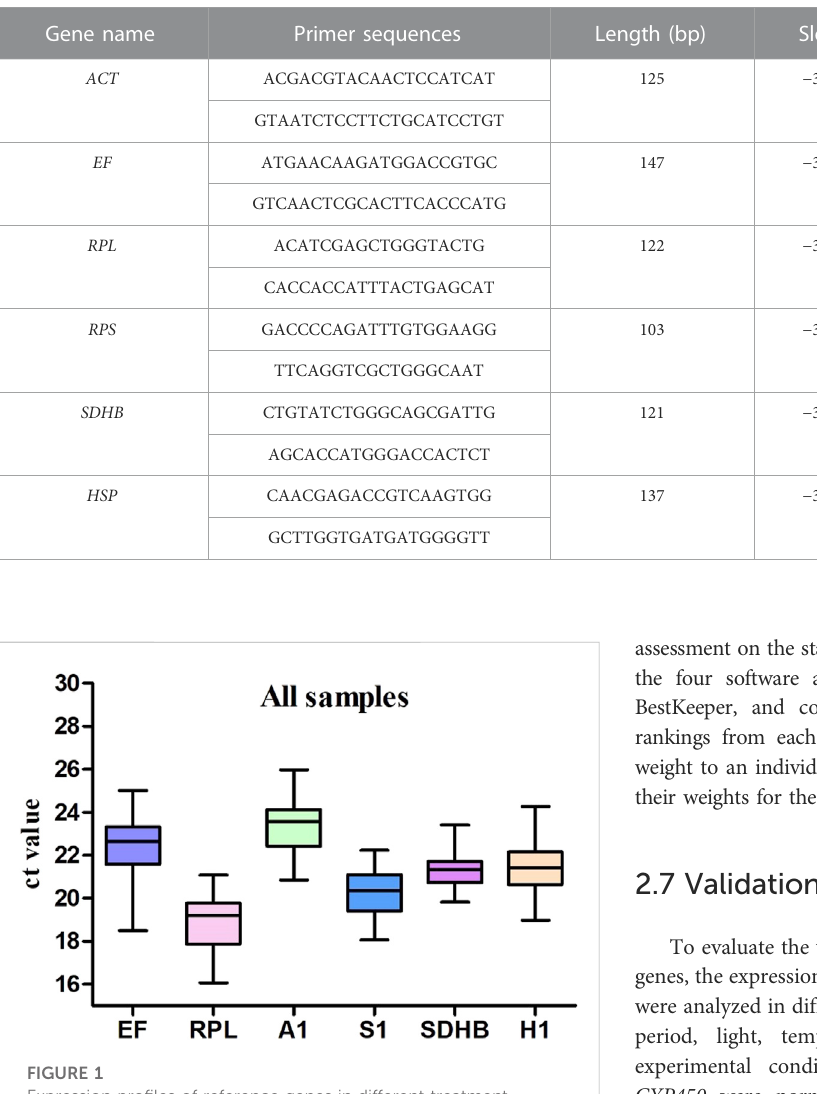
TABLE 2 Primer speci fi city of six reference genes for qRT-PCR.